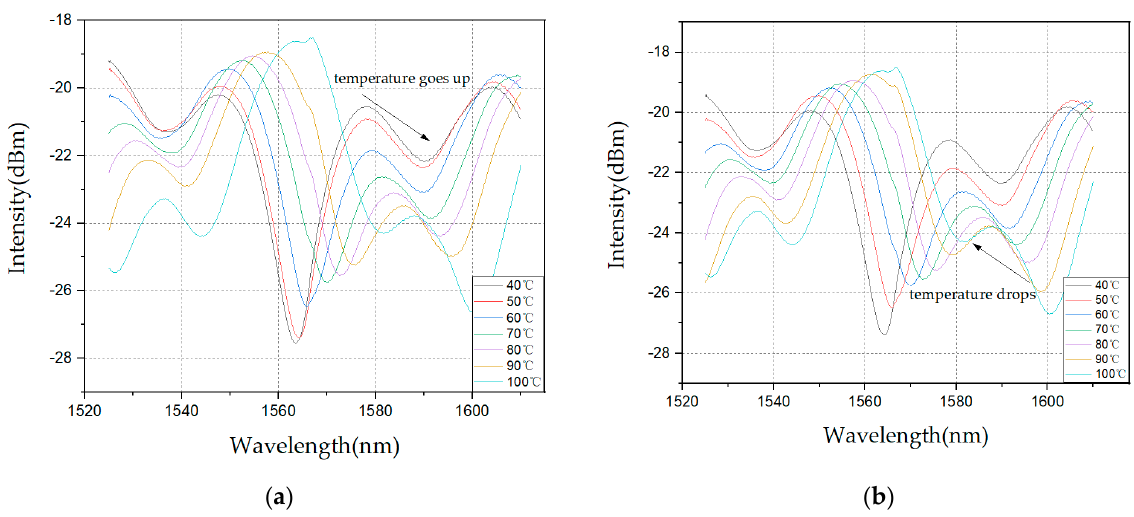
Figure 13. The performances for the repeatability and stability of the sensor: ( a ) the interference Scheme 40. to 100 °C; and ( b ) the interference spectrum with temperature drops from 100 to 40 °C.